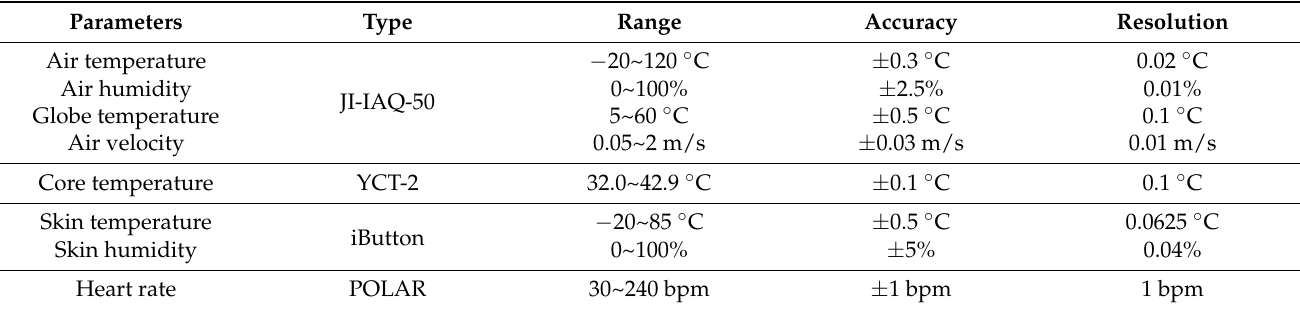
Table 1. Details of instruments used in the study.